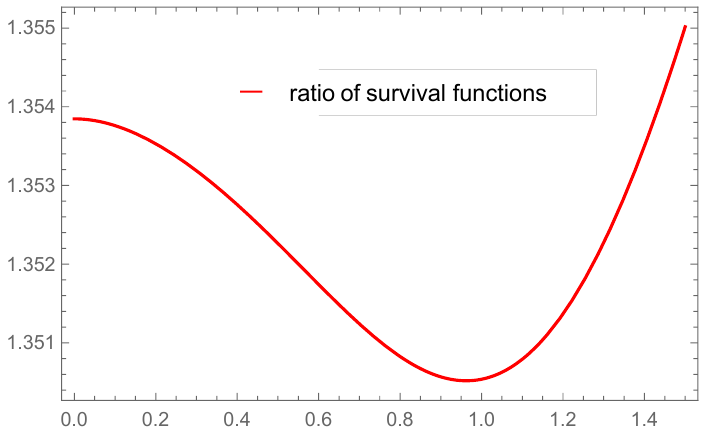
Figure 2. Plot of the ratio of survival functions of V 2:2 and W 2:2 for x ∈ [ 0,1.5 ] in Example